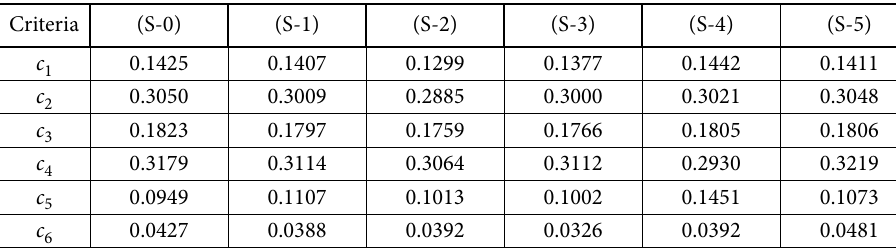
Table 14. The weights of criteria in different situations